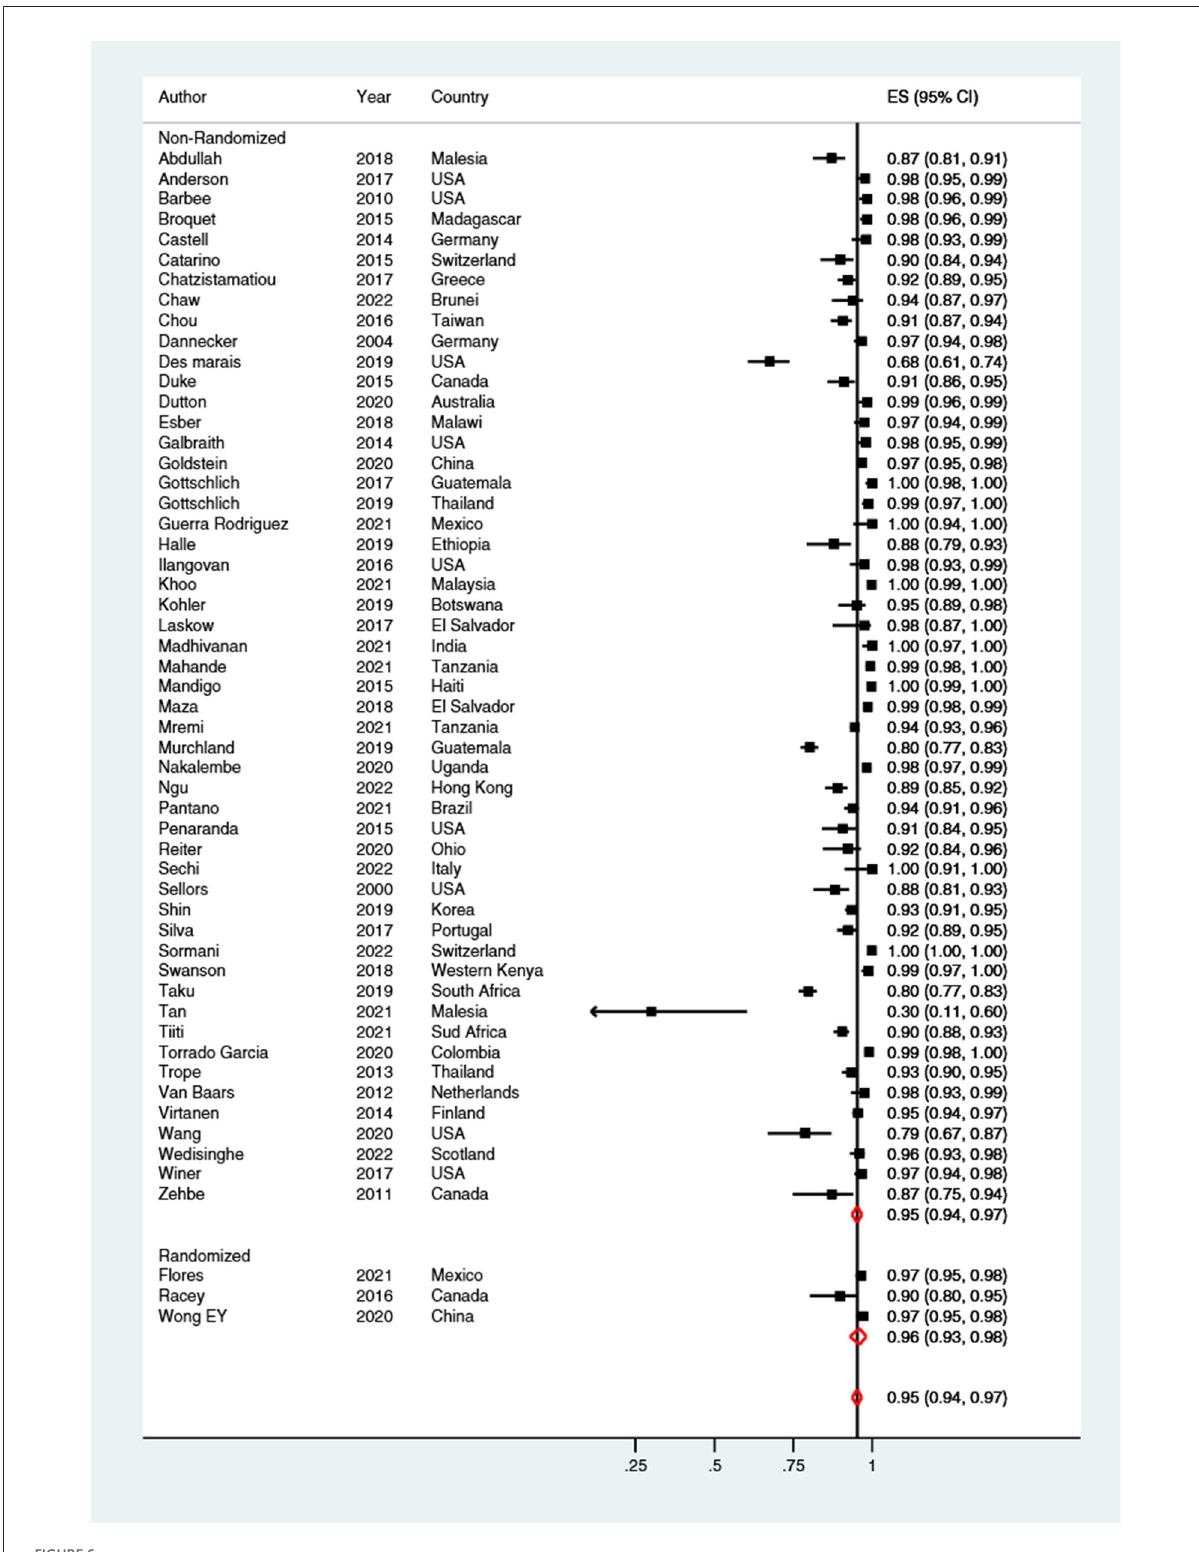
FIGURE6 Forest plot of the proportion of women who found self-sampling acceptable. Homogeneity ( I -squared): 95.9%; Cochrane’s Q test for between-group differences: Q = 1,307.30; df = 54; p <